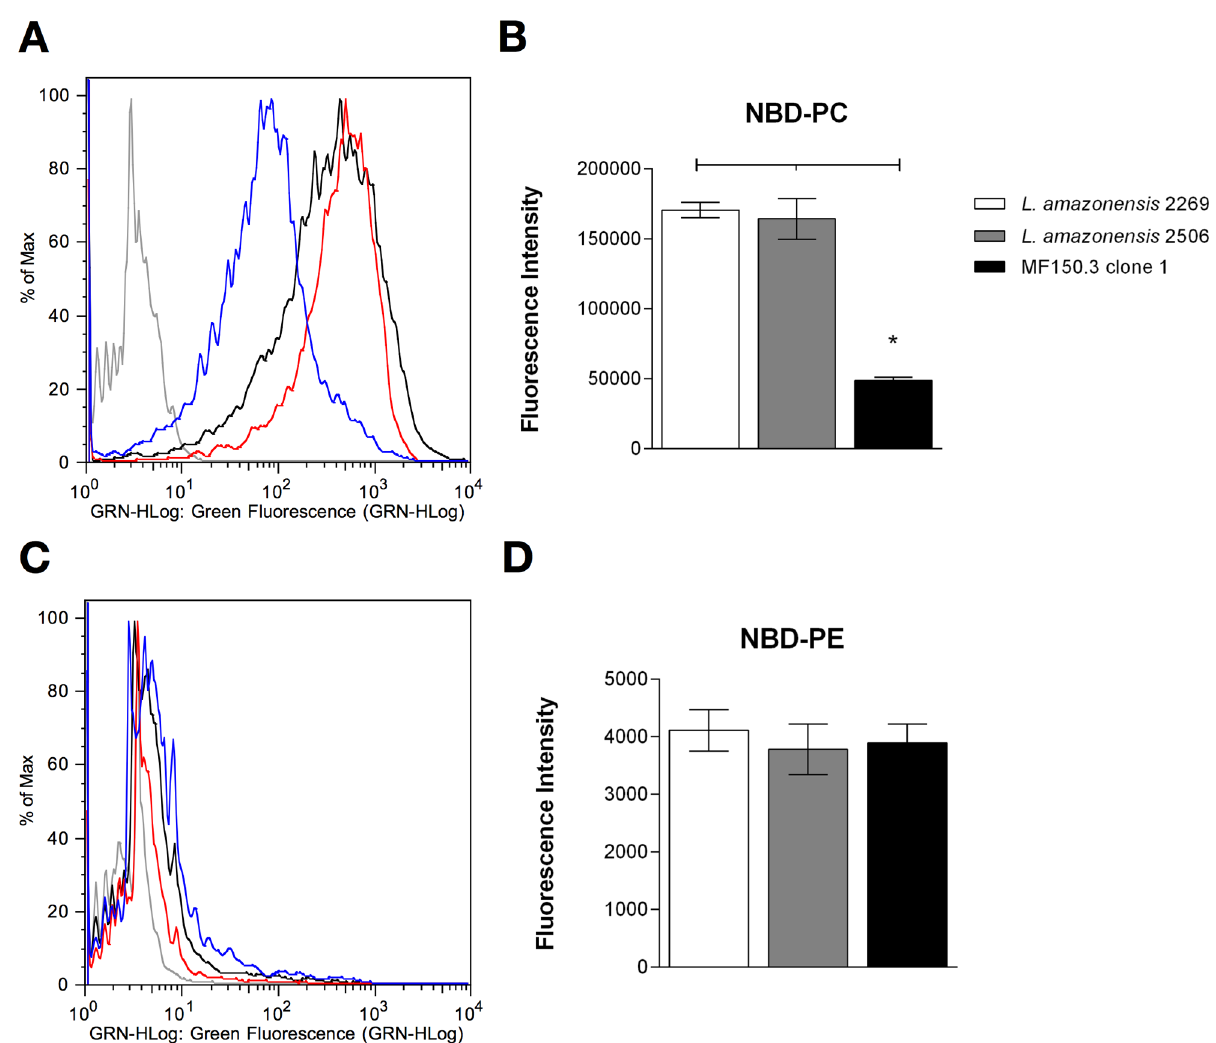
Figure 3. Phospholipid accumulation in L.amazonensis lines. Promastigotes were incubated with fluorescent phospholipid analogues NBD-PC or NBD-PE for 30 minutes at 25 u C, washed and evaluated as described in the Methods by flow cytometry (A and C) or spectrofluorimetry (B and D). (A and C) Non-labelled parasites are shown in gray, while labelled parasites L. amazonensis M2269, 2506 and MF150.3-1 mutant with NBD-PC (A) or NBD- PE (C) are represented by black, red and blue lines, respectively. Histograms correspond to a representative experiment from three independent experiments. (B and D) Fluorescence intensity of labelled parasites with NBD-PC (B) or NBD-PE (D) measured by spectrofluorimetry. Unlabelled parasites were used as the blank reading. The average 6 standard deviation of three independent experiments is shown. Statistical analysis was performed with One Way ANOVA, followed by the Tukey post-test. * p , 0.01.